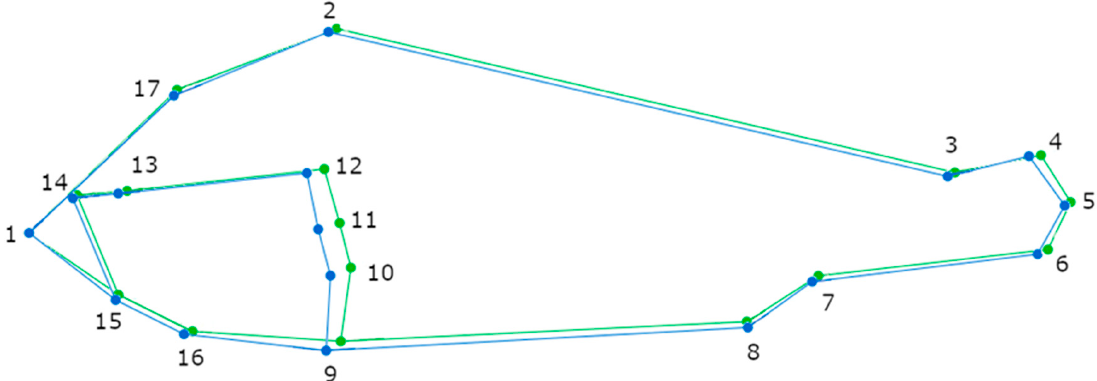
Figure 4. Wireframe of the average shape between the specimens of UEP1 and UEP6, Table 1. Blue, UEP1—Ciénaga de Capote, and green, UEP6—Ciénaga del Jobo.